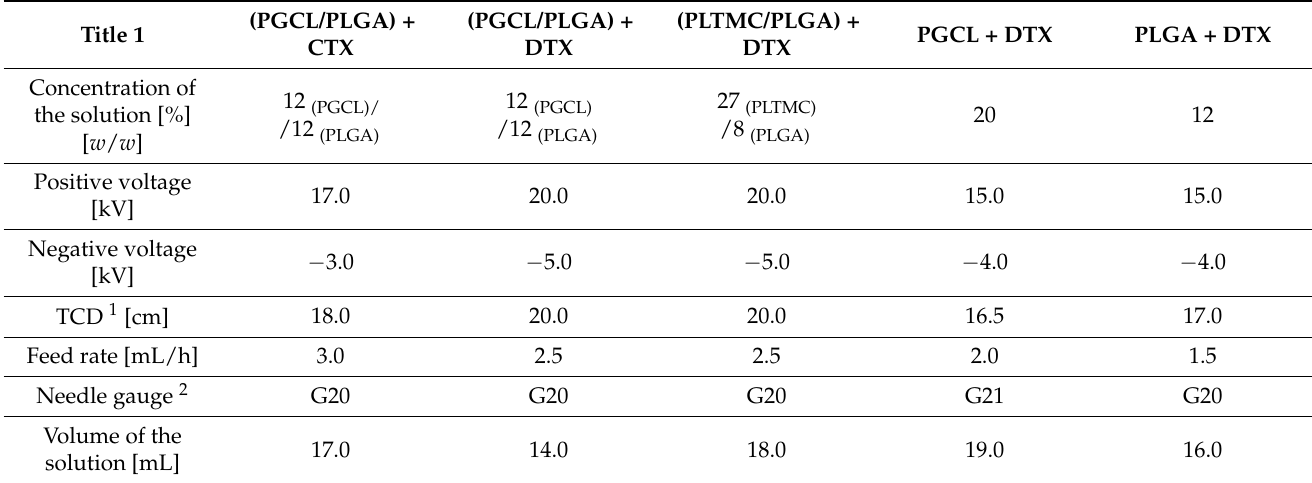
Table 1. Parameters of the electrospinning